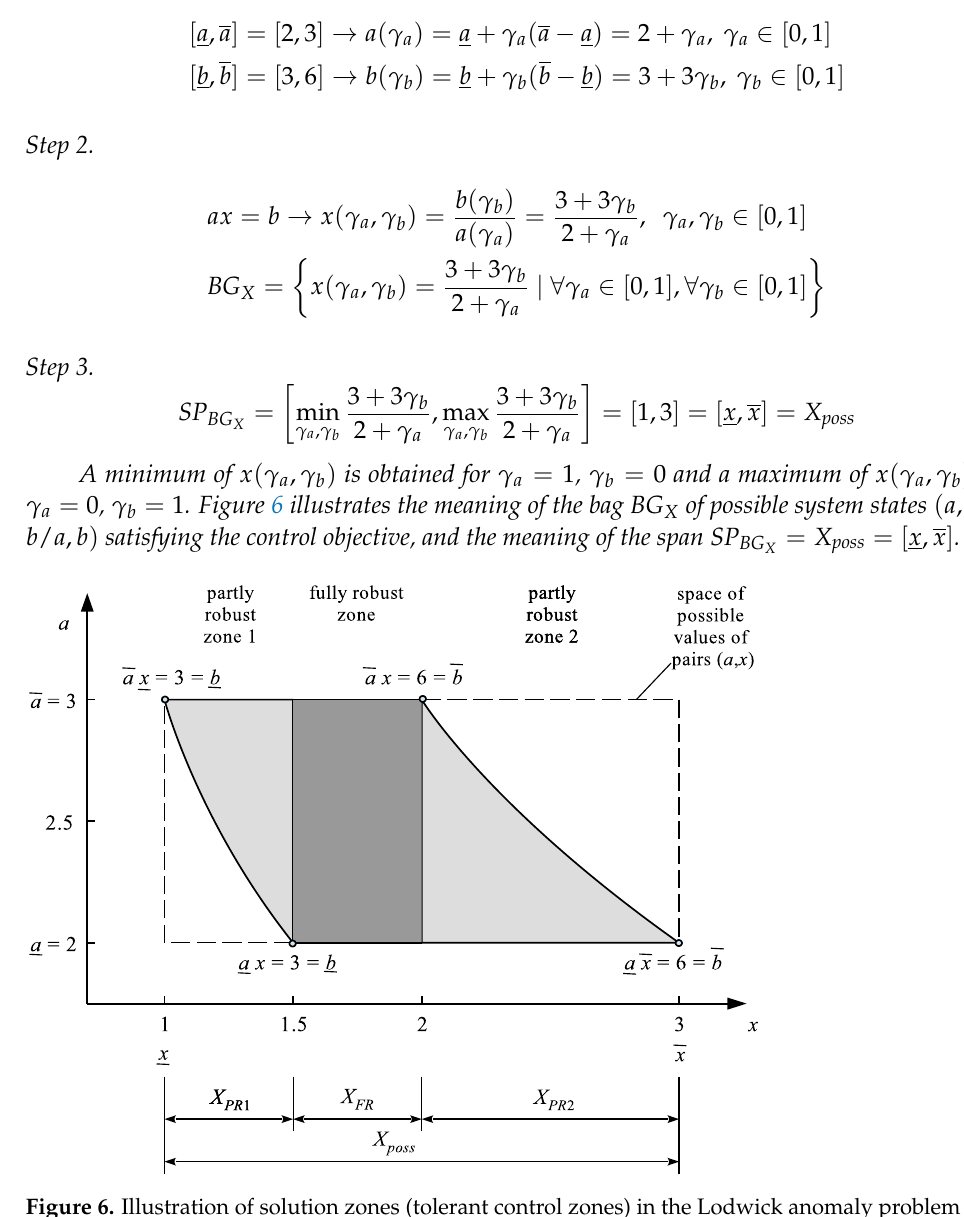
Figure 6. Illustration of solution zones (tolerant control zones) in the Lodwick anomaly problem